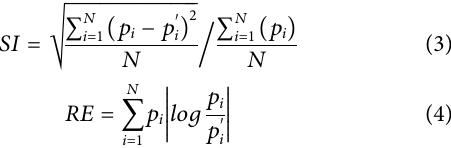
Frontiers in Energy Research |